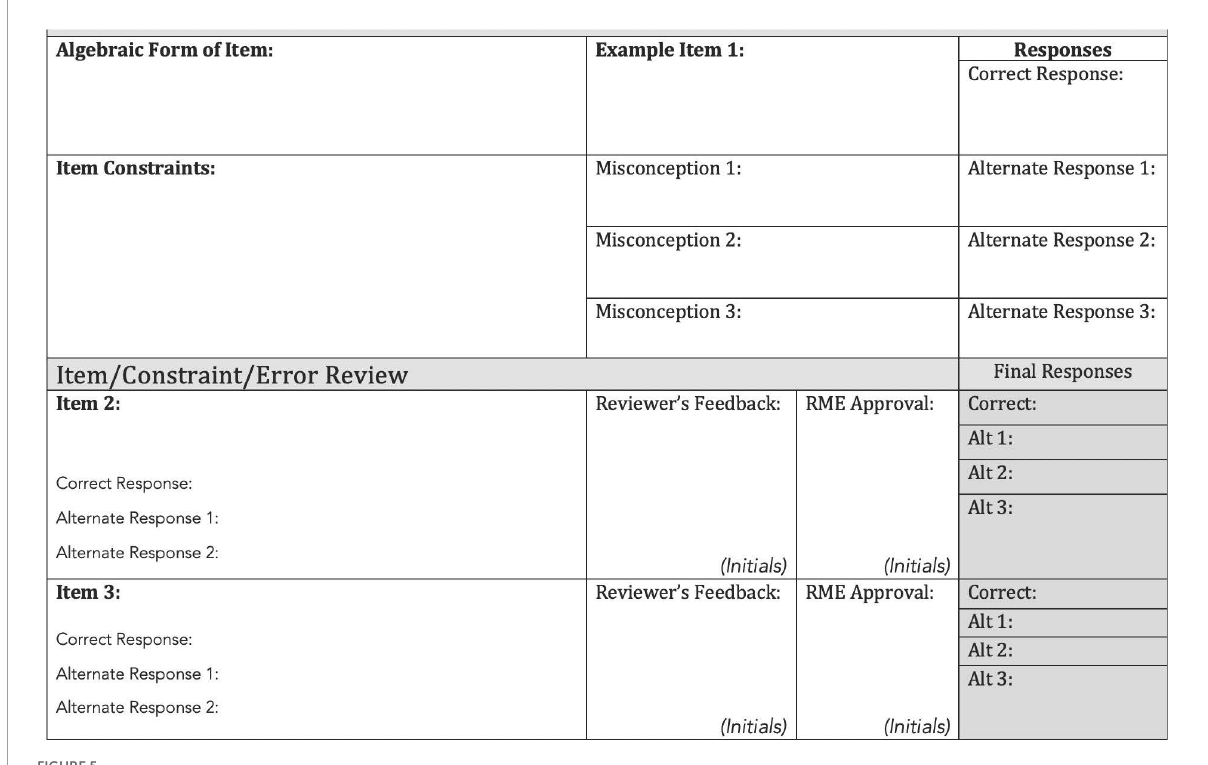
FIGURE5 Item model